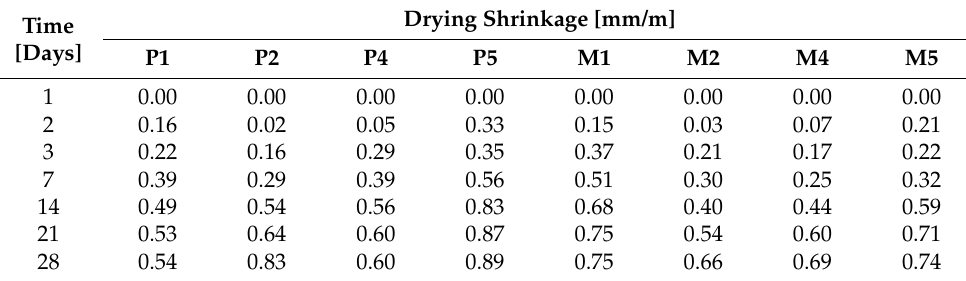
Table 9. Shrinkage of plasters and masonry